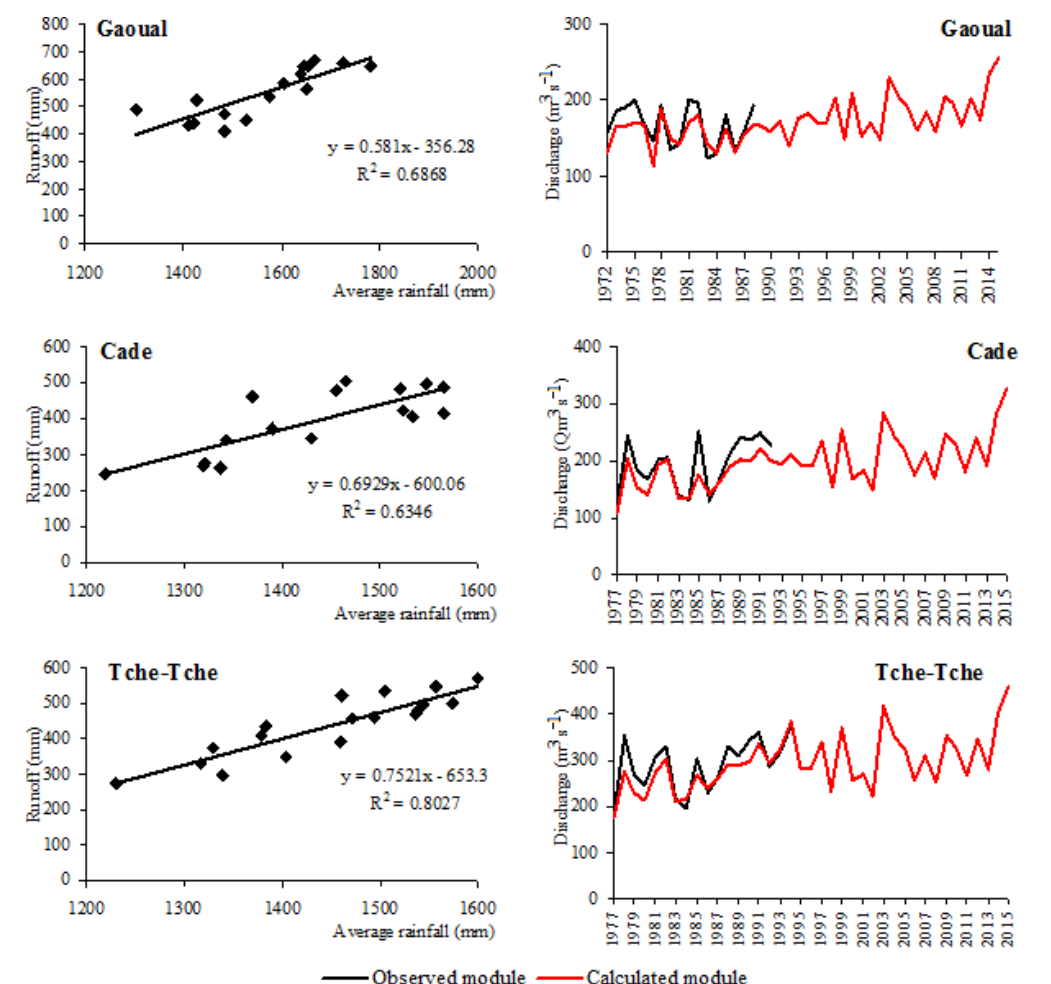
Figure 9. Relation between runoff and annual mean rainfall (left panels) and comparative evolution of observed and calculated annual modules (right